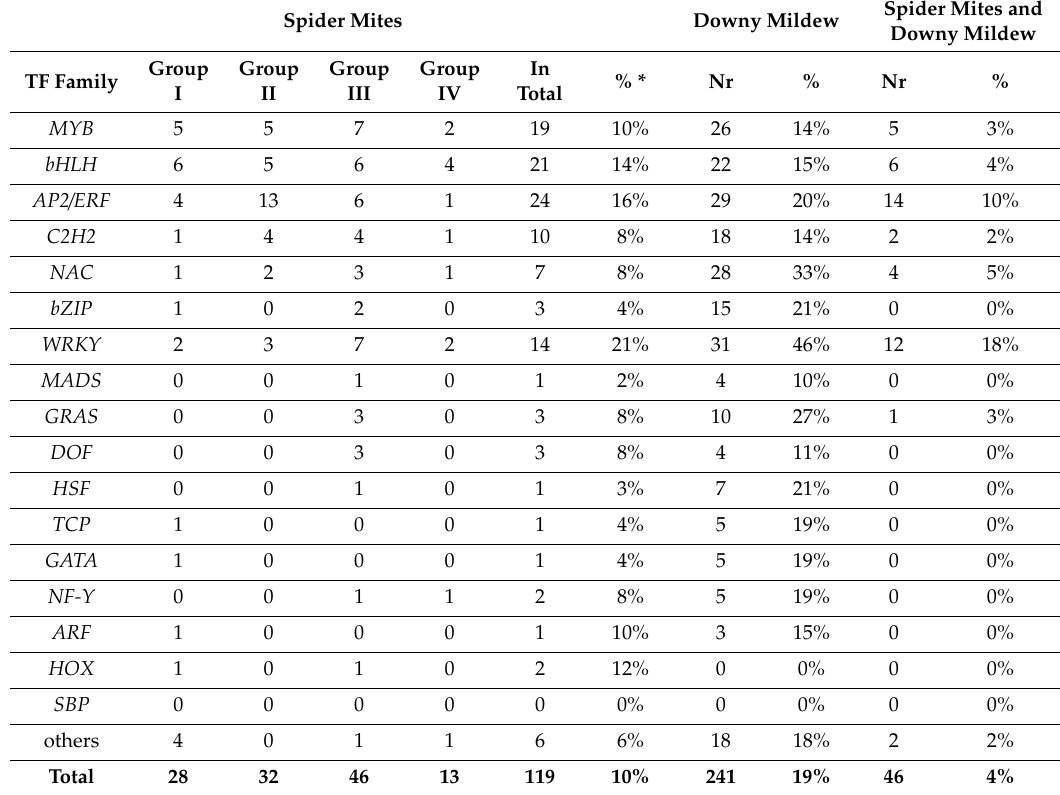
*: Percentage of genes per category that is affected by the indicated stress.